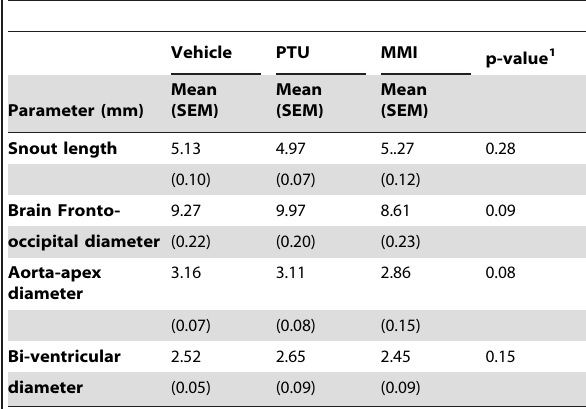
Table 4. Morphometic Analysis of Embryos at E18.5 based on MicroCT